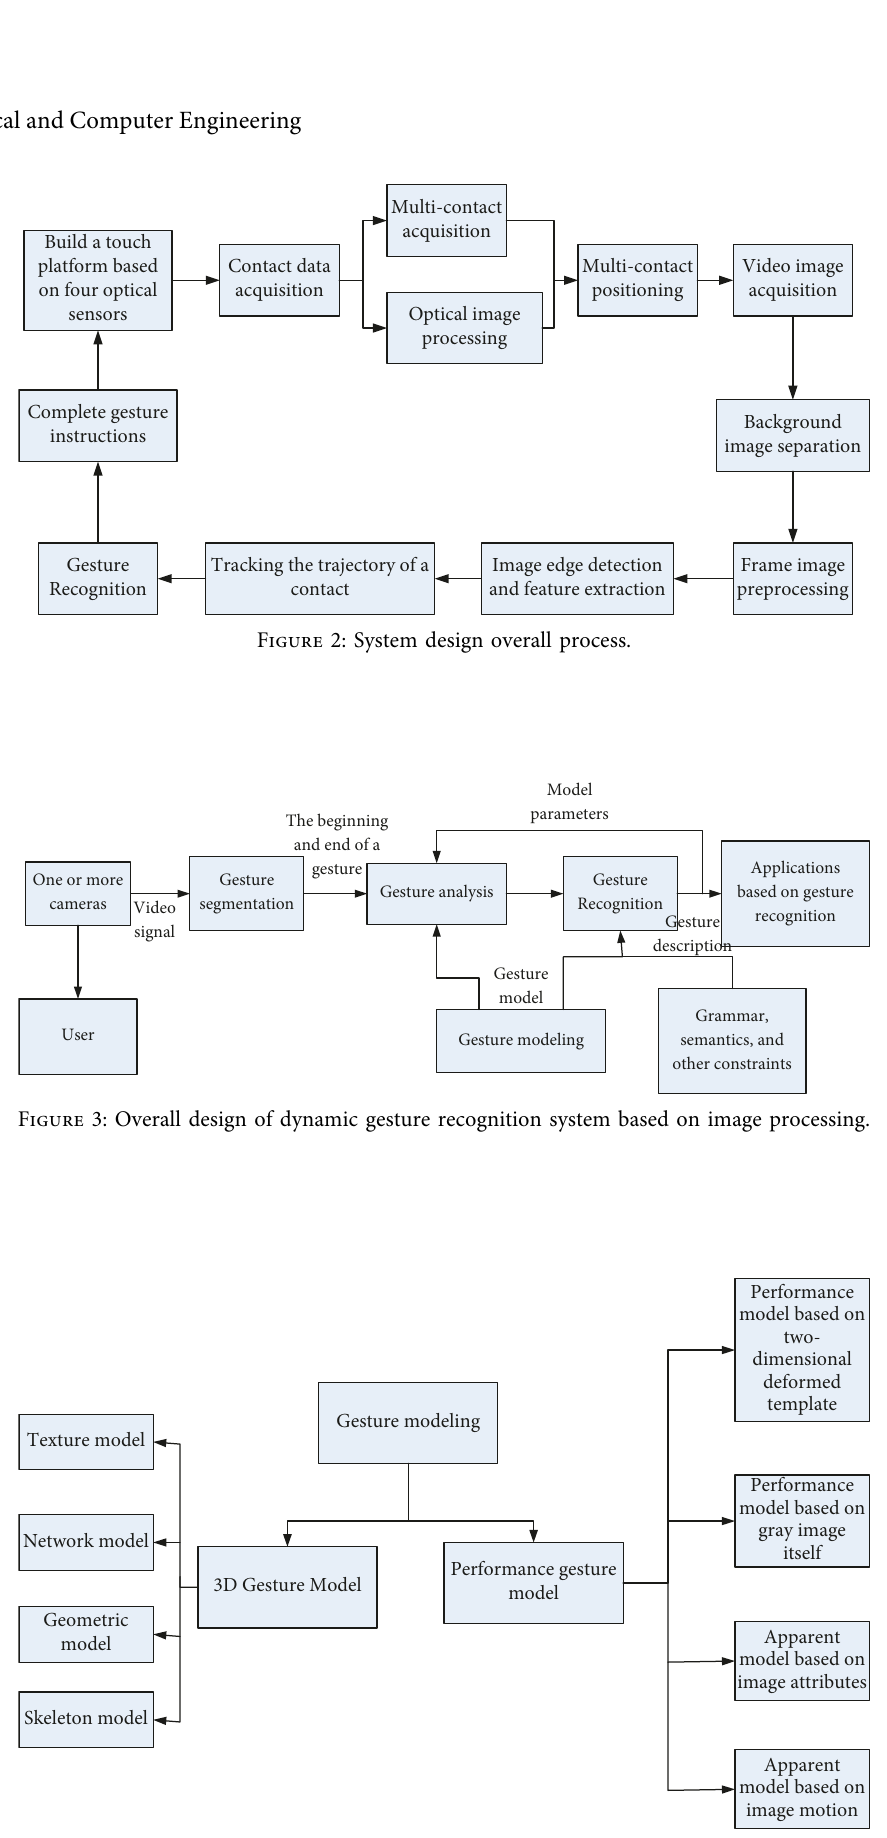
Figure 4: Gesture modeling module design basic